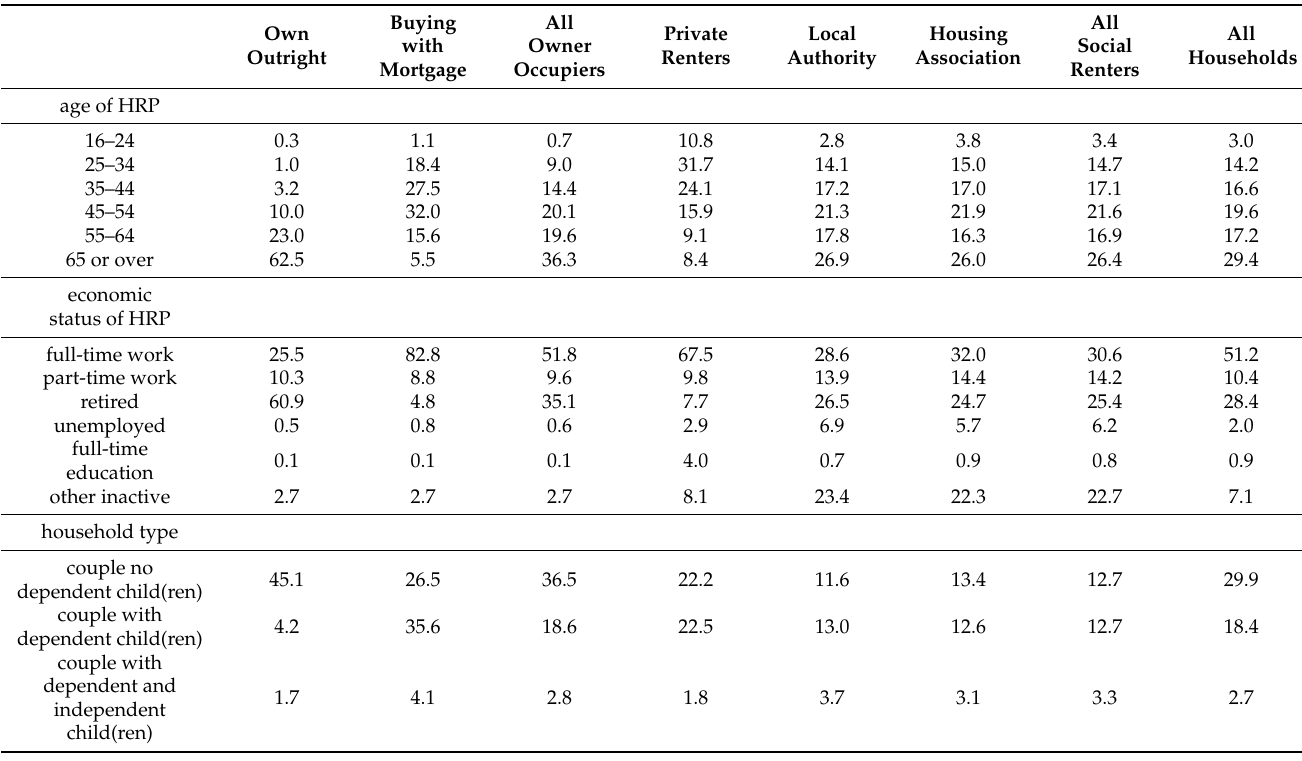
Table A3. Demographic and economic characteristics, 2019–2020